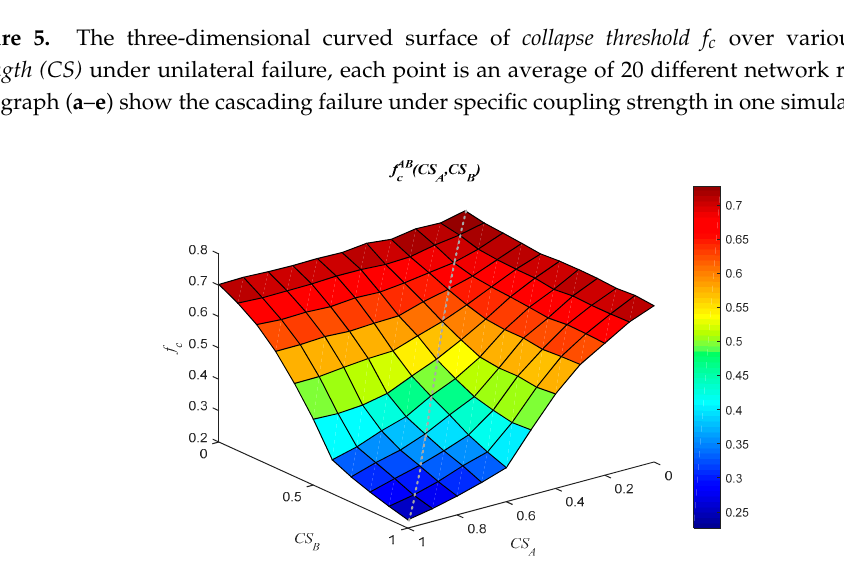
Figure 6. The three-dimensional curved surface of collapse threshold f c over various coupling strength under bilateral failure, each point is an average of 20 different network realizations.